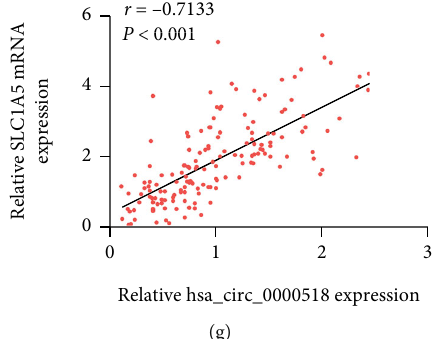
Figure 5: SLC1A5 is a direct regulator to miR-330-3p. (a) The putative binding sites of miR-330-3p on SLC1A5. (b) Dual-luciferase assays con fi rmed the interaction of SLC1A5 with miR-330-3p. (c) The transcriptional level of SLC1A5 mRNA in NSCLC and normal tissue pairs ( n = 160 ) was determined by qRT-PCR. (d) SLC1A5 protein expression was assessed by western blot in 3 paired NSCLC and normal tissues. (e) The level of SLC1A5 protein expression was assessed by western blot in normal and NSCLC cells. (f) miR-330-3p and SLC1A5 levels are inversely related. (g) Positive correlation between hsa_circ_0000518 and SLC1A5. ∗∗ p < 0 : 01 , ∗∗∗ p < 0 : 001